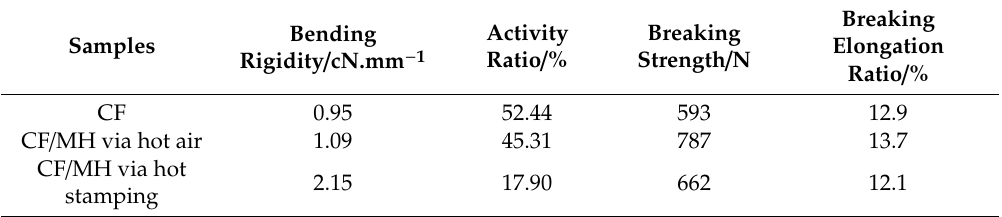
Table 4. Physical properties of CF and CF / MH via hot air and hot